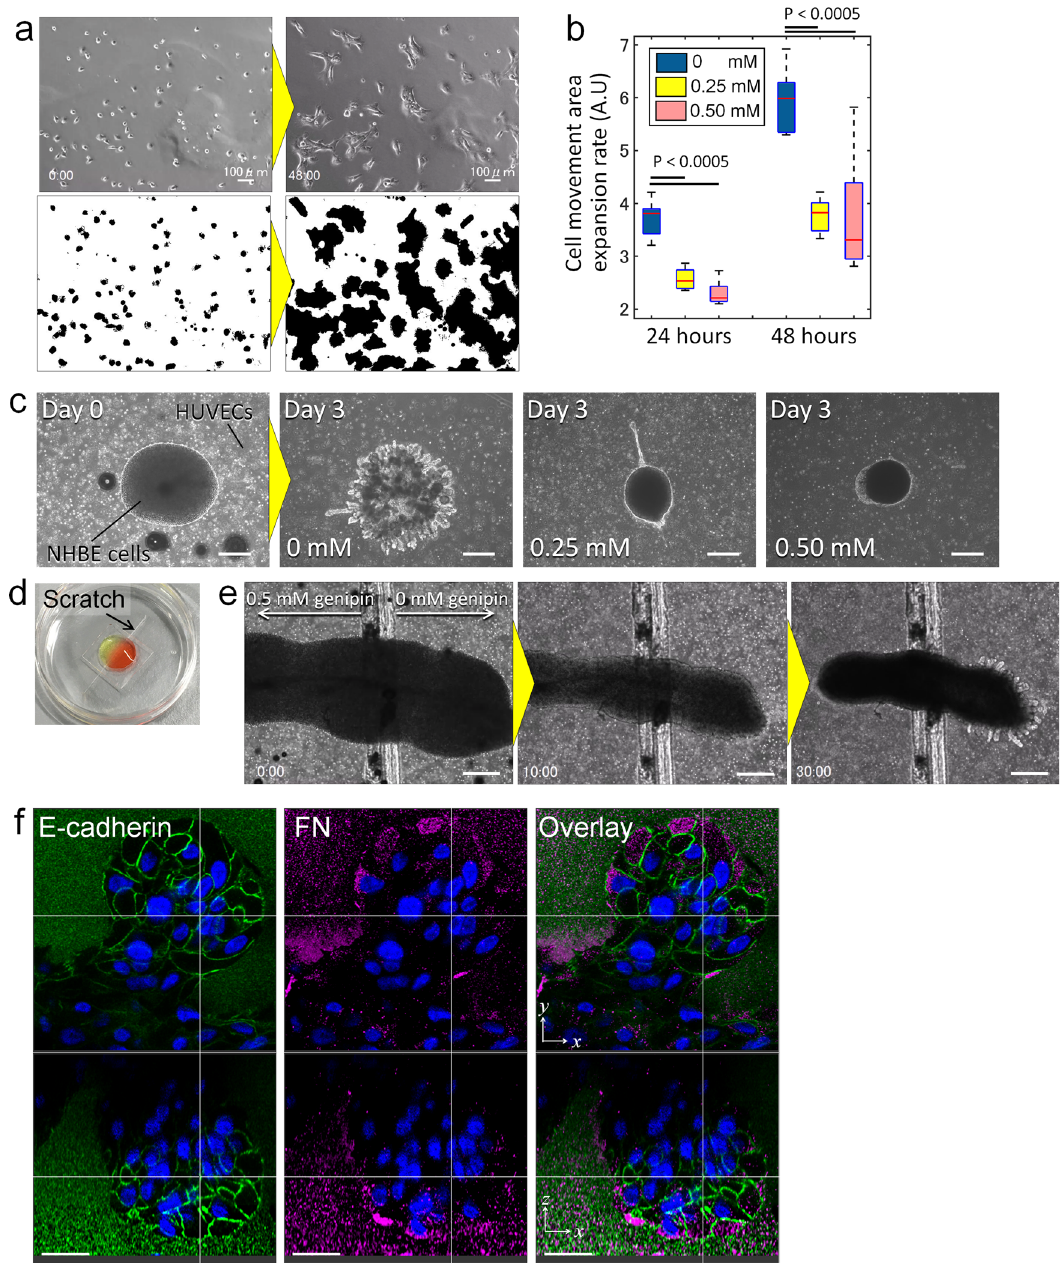
Fig. 7 Effects of ECM stiffness on cellular behaviour and 3D morphogenesis. a Time-lapse images of NHBE cells on a dish covered by matrigel with genipin to enhance the stiffness of matrigel. The images were converted to binary to calculate the area of cellular movement. b Quantitative comparison of cell movement area with different genipin concentrations after 24 h and 48 h. The data shown are the means ± SDs ( n = 9). c Phase contrast images of 3D cultured NHBE cells. HUVECs were dispersed in matrigel while a high density of NHBE cells was placed in the centre of the matrigel. Genipin was mixed with matrigel at a concentration of 0, 0.25, and 0.5 mM to analyse the effects of ECM stiffness on the branching morphogenesis of NHBE. d Demonstration of ECM localisation by a scratch made on the culture dish. Yellow- and red-coloured matrigel were localised on either side of the scratch. e Time-lapse images of 3D culture of NHBE cells. The left part of the image shows matrigel with 0.5 mM genipin while the right part of the image shows matrigel that does not contain genipin. f Section imaging of a developed branch in matrigel showing E-cadherin, FN, and nucleus staining. The complete time-lapse movie for part a is shown in Supplementary Movie 16. Scale bar: 100 μ m ( a ), 500 μ m ( c , e ), 30 μ m ( f